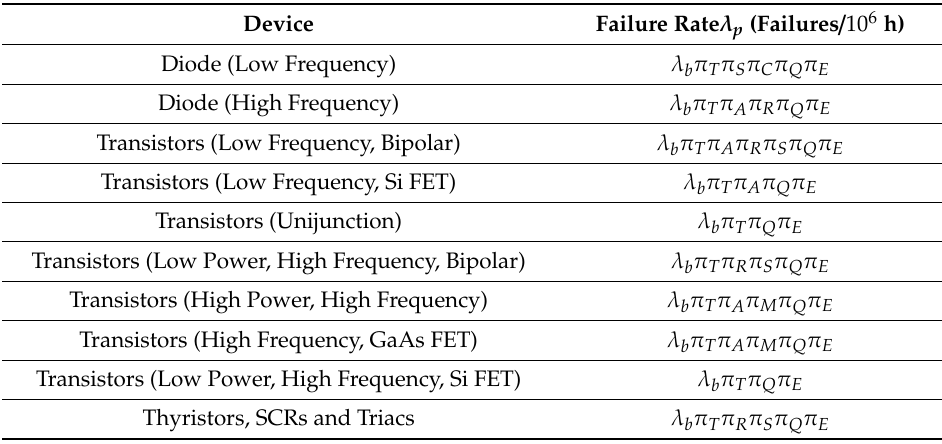
Table 3. Definition of failure rates for di ff erent devices according to the MIL-HDBK-217F